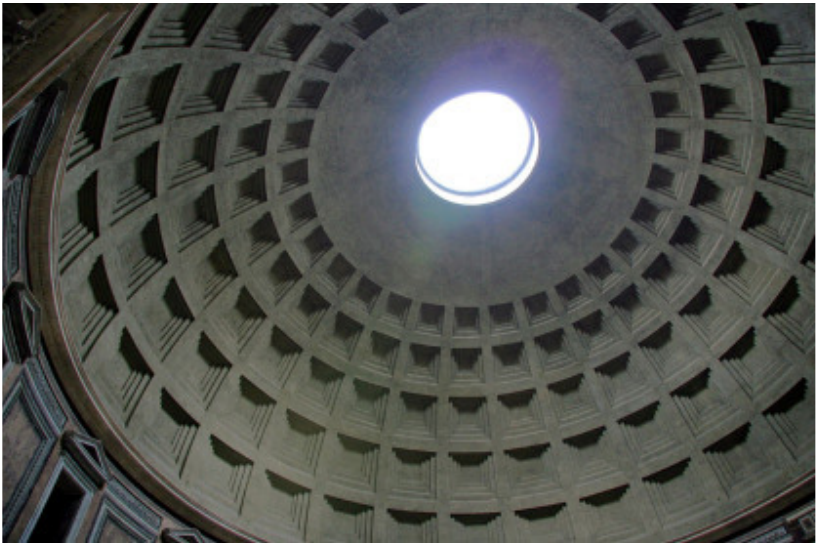
Figure 10. Concentric nerves used for the construction of the Pantheon in Rome. A rather original formula used to balance the forces induced by the cupola is the one created in 751 A.D. at the Seokguram temple, whereby counterweights or ‘forearms’ are used, which act as both levers and wedges. As far as we can report, it is the only dome possessing such artifacts among its features (Figure 11).